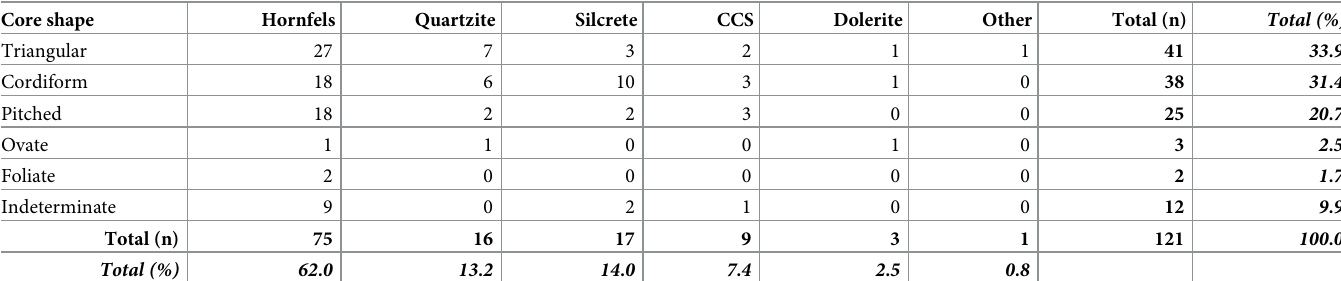
Table 4. Frequencies of Nubian core shapes at Tweefontein by raw